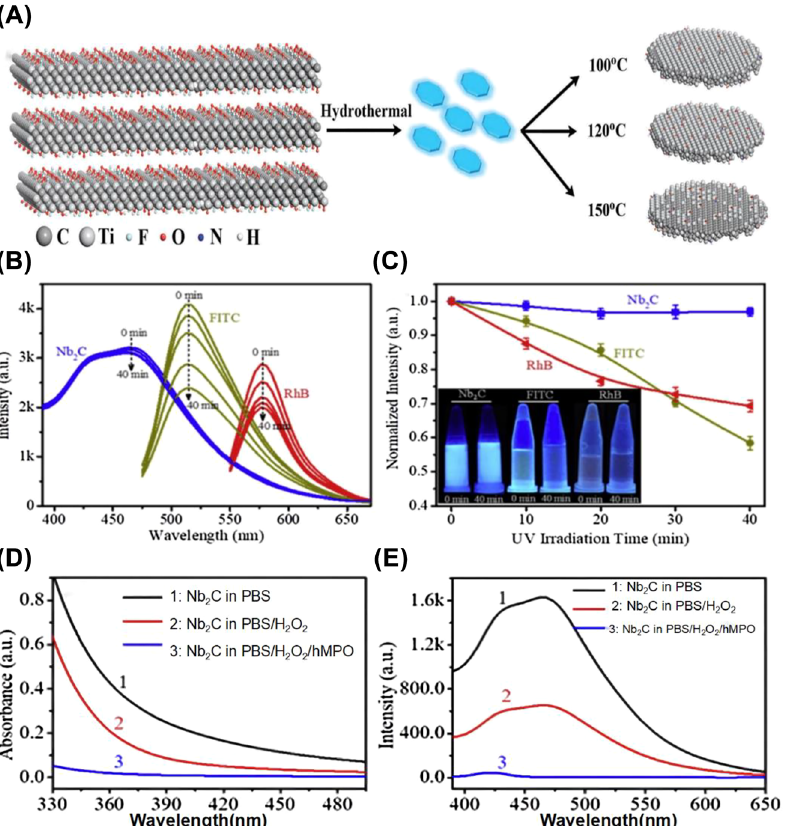
Figure 6: Fluorescence imaging of